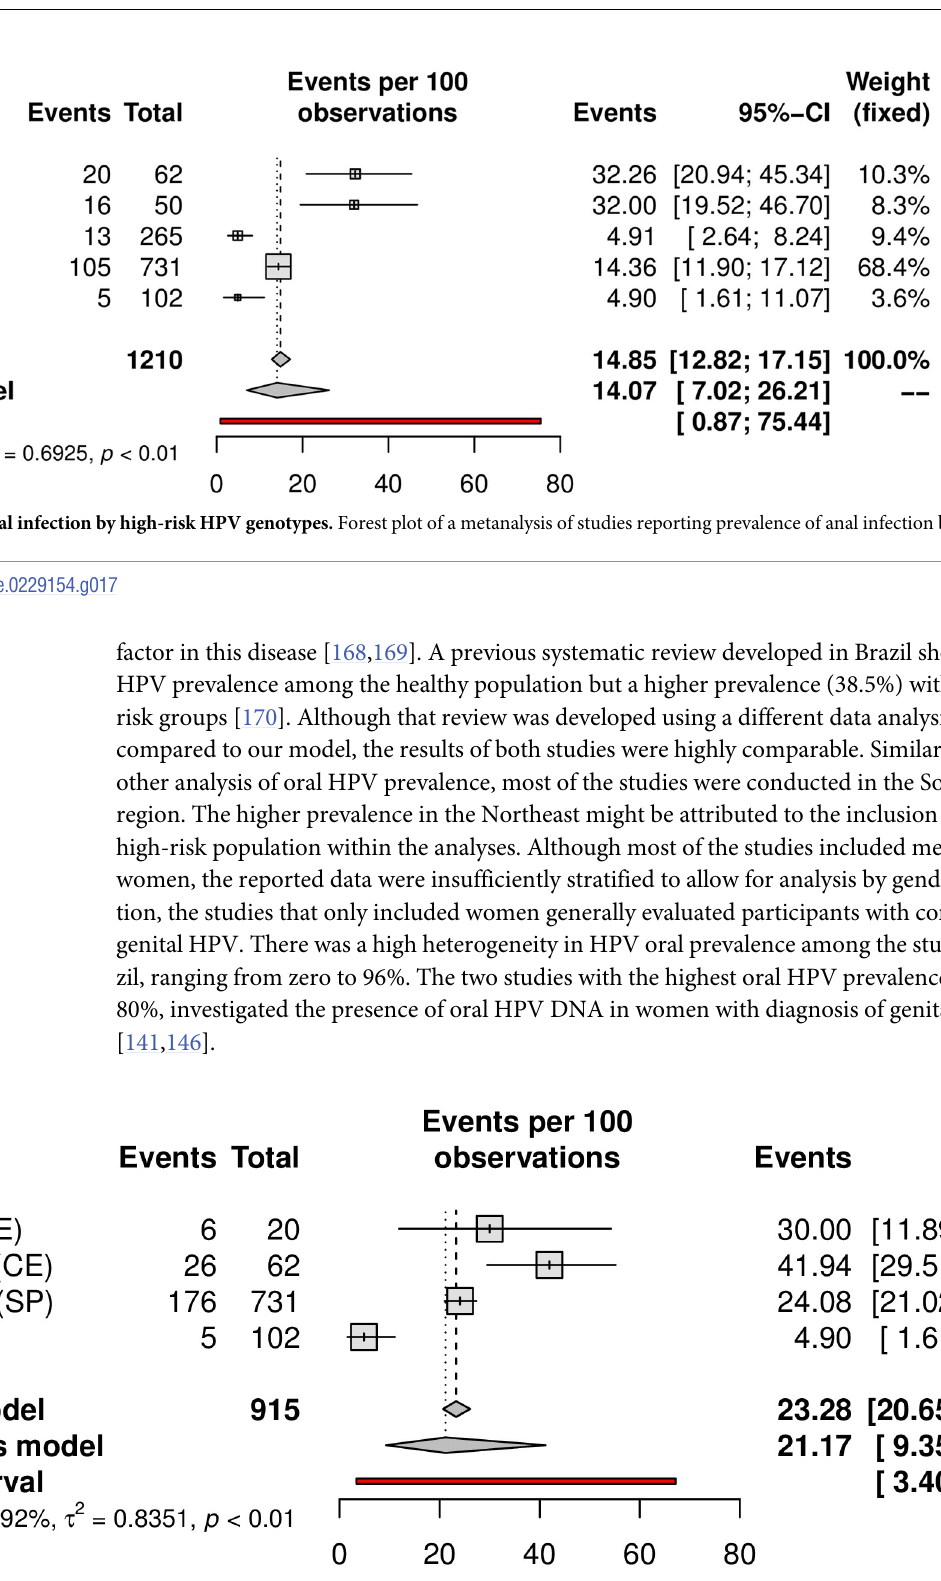
PLOS ONE | https://doi.org/10.1371/journal.pone.0229154 February 21,